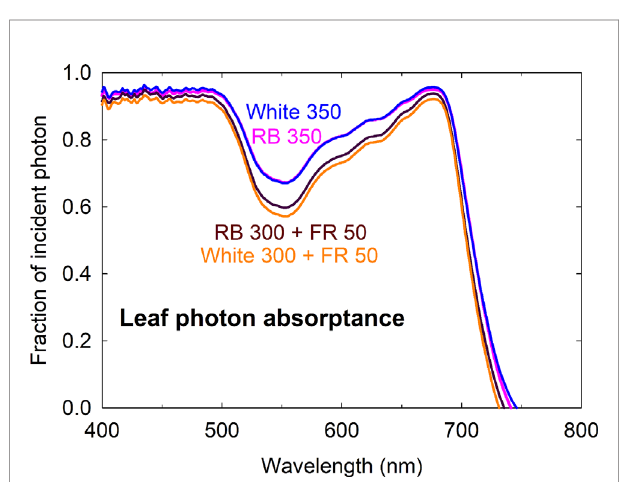
FIGURE 6 | Leaf photon absorptance of lettuce grown under four spectral treatments. RB, red and blue; FR, far-red. The numbers following each type of light ( e.g. RB 350) indicate photon fl ux density in m mol m − 2 s − 1 .